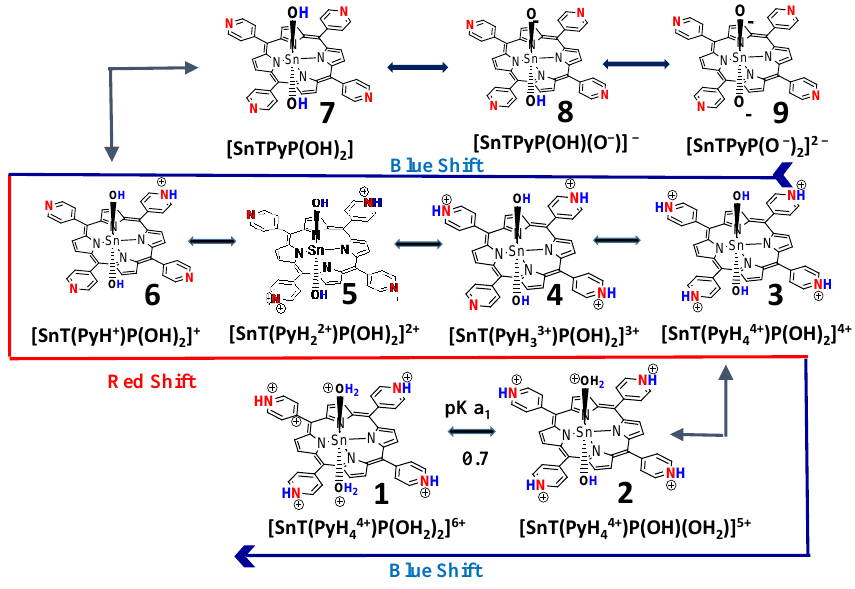
Figure 4. 1 H NMR of SnTPyP in CD 3 CN/D 2 O (8/2, v / v ) under various pH conditions. The pH was adjusted by adding deuterated sulfuric